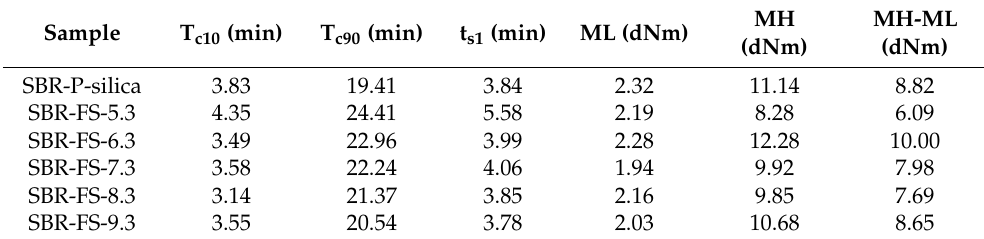
Table 3. Cure characteristics of rubber composites filled with P-silica and FS-SiO 2 (T c10 , T c90 , t s1 , ML, MH,